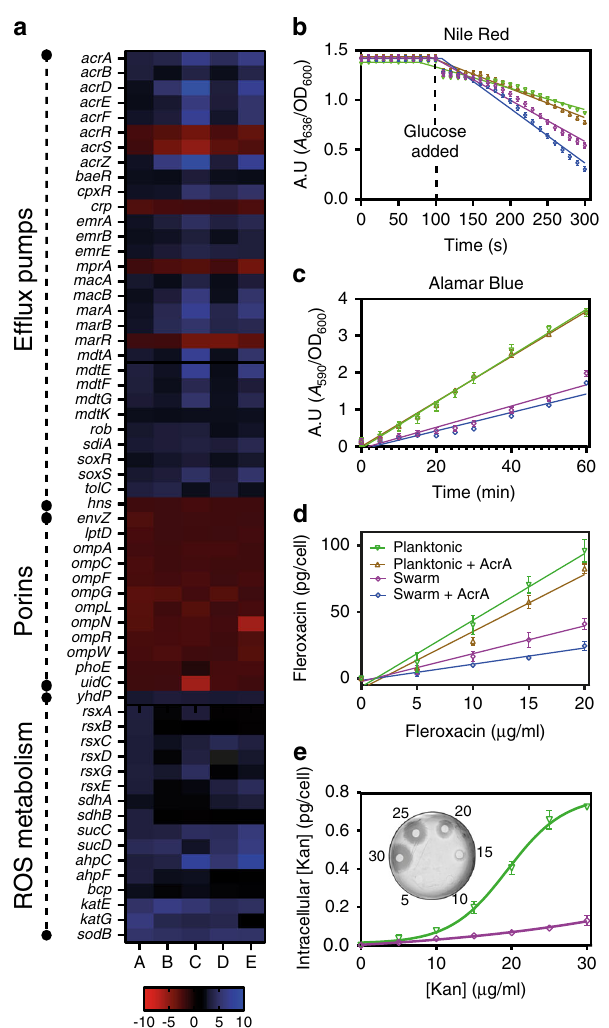
Fig. 5 Mechanism of SR. a Comparison of log 2 fold changes in gene expression. (A) Swarm vs. Planktonic, (B) Swarm + Kan 20 vs. Swarm, (C) Swarm + Kan 20 + AcrA vs. Swarm, (D) Swarm + Cip 2.5 vs. Swarm, (E) Swarm + Cip 2.5 + AcrA vs. Swarm. The concentration of AcrA was 0.1 μ g/ ml, and the log 2 fold change cutoff value was 2. About 25 genes encoding ef fl ux pump components representing all fi ve classes of pumps and their regulators were upregulated in swarm cells (~2 – 3 fold), while ten genes expressing different porins or their regulators were downregulated (~2 – 3 fold). Except for porins, all these genes were further upregulated (~2 – 6 fold) in swarm cells under antibiotic stress (Kan and Cip). The presence of AcrA also increased expression of these same genes (~2 – 9 fold). Twenty-three genes for energy metabolism (~2 – 4 fold) and 16 genes related to ROS catabolism (~2 – 6 fold) were also upregulated. b Ef fl ux assay using Nile red indicator dye ( n = 3). Glucose was added at 100 s. Nonlinear regression analysis of Planktonic, Planktonic + AcrA, Swarm, and Swarm + AcrA data sets (see d for color key) yielded rate constants of 1.001 × 10 − 0.6 , 8.669× 10 − 0.7 , 6.630 × 10 − 0.6 , and 1.165 × 10 − 0.6 , respectively. A.U. = (A 636 / OD 600 ). The time required for 50% Nile Red ef fl ux or t eff50, was signi fi cantly low in swarm cells (230 s for swarm and ≥ 300 s for planktonic cells; compare purple vs. green lines; p < 0.0001 for the two values). Addition of AcrA yielded t ef fl ux50 with a 1/10th increase in swarm cells (207 s, p = 0.0003 for Swarm + AcrA vs. Swarm from a two-tailed T test) and 1/20th increase in planktonic cells (282 s, compare brown vs. blue lines; p = 0.0038 for planktonic + AcrA vs. Planktonic from a two-tailed T test). c Membrane permeability assay using Alamar Blue indicator dye ( n = 3). Nonlinear regression analysis of Swarm, Swarm + AcrA, Swim, and Swim + AcrA data sets (see d for color key) produced slopes of 0.06254, 0.06103, 0.02876, and 0.02498 respectively. A.U. = (A 590 /OD 600 ). d Estimated intracellular concentration of Fleroxacin ( n = 3). The slopes of the fi tted lines of data sets for Swarm, Swarm + AcrA, Planktonic, and Planktonic + AcrA were 2.090, 1.220, 5.010, and 4.290, respectively. e Estimation of intracellular antibiotic concentration in E. coli using the Disc- diffusion assay. See “ Methods ” for details. The inset image shows one representative plate with discs containing planktonic samples incubated with the Kan concentrations indicated by the numbers. Inhibition zones around the fi lter discs were compared to those from a standard curve generated with known concentrations of kanamycin. Swarm cells show ~8- fold decrease in intracellular [Kan] at Kan 30 compared to planktonic cells. Data are presented as mean values± SD in ( b – e ). Source data are provided as a Source Data fi